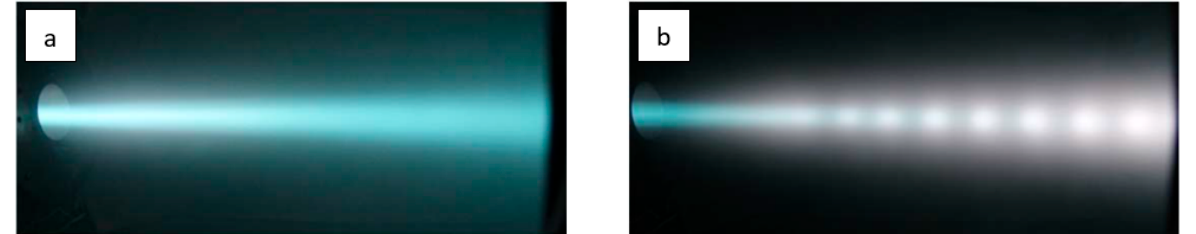
Figure 16. Photograph of a helium beam-plasma glow in the absence ( a ) and in the presence ( b ) of alternating bands. Beam current: a—180 mA, b—200 mA. Accelerating voltage 10 kV, pressure 40 Pa [119].